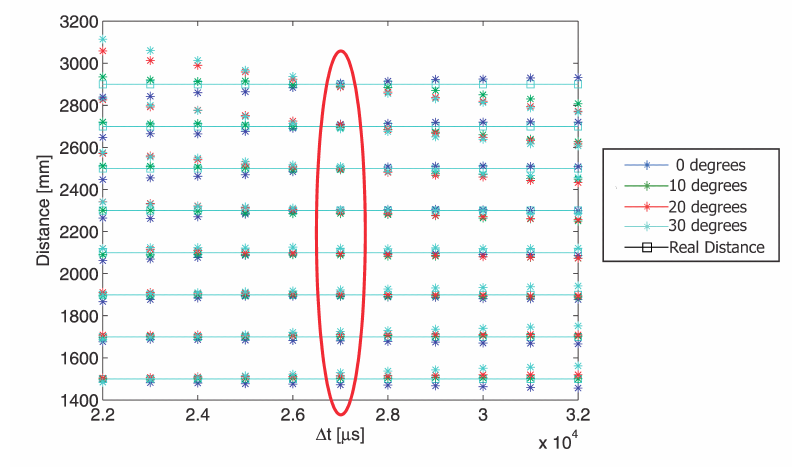
Figure 12. Distance estimation as a function of (cid:52) t . Note that best accuracy was obtained with (cid:52) t = 27 ms. Consequently, this was the optimal exposure time difference for the distance estimation process.